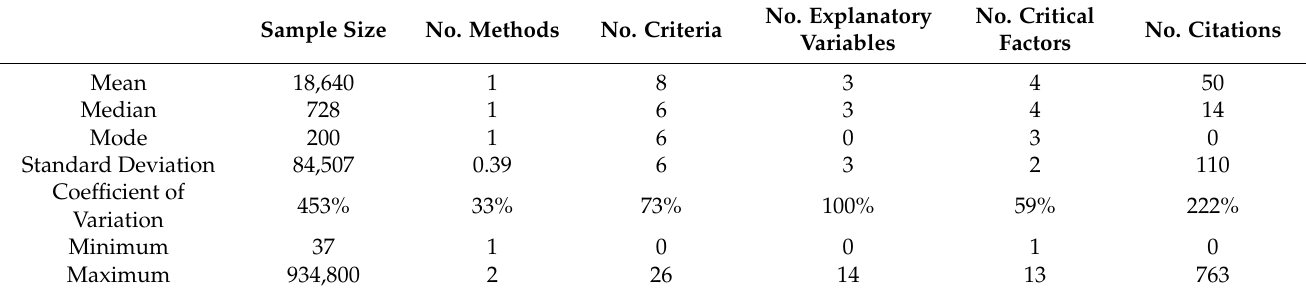
Table 2. Statistical measures applied to all collected data.